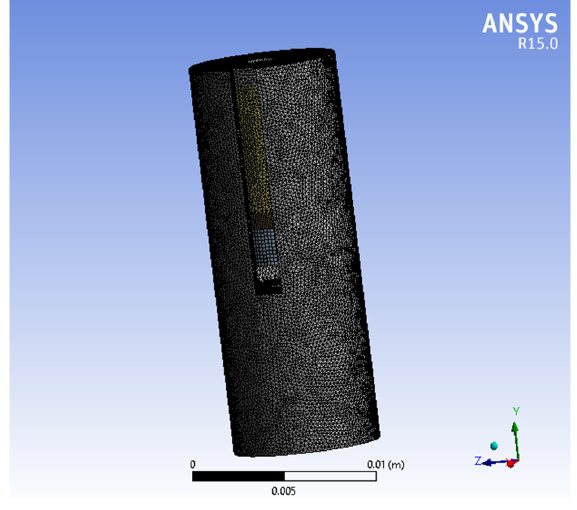
Figure 2. Mesh of the actuator model.